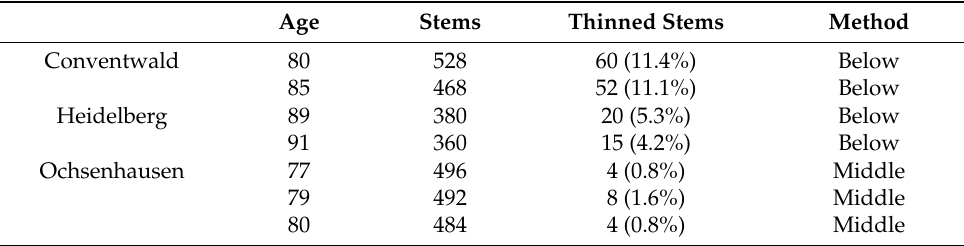
Table A2. Three thinning regimes applied at the sites. Stems are the stems before thinning took place. The percentage is the proportion of thinned stems to stems before thinning.